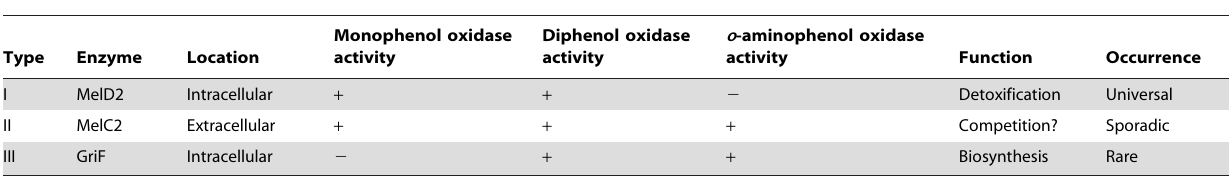
Table 3. Three types of Streptomyces PPOs and tentative distinctions.